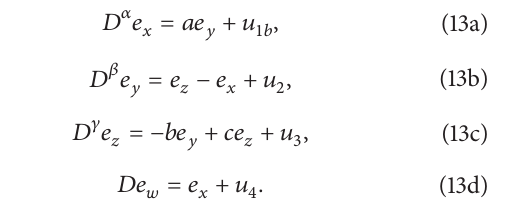
Figure4:Thegeneralsynchronizationof(a),(b)the 𝑥 and 𝑦 responseswhen {𝛼,𝛽,𝛾,𝑎 1 , 𝑏 1 , 𝑐 1 , 𝑎 2 ,𝑏 2 ,𝑐 2 } = {0.96, 0.96, 0.96, 4, 1, 0.65, 4, 1, 0.65} for Case A, (c) the 𝑥 response under the same condition with additive noise with amplitude 0.1, (d) the response when , 𝑏 , 𝑐 , 𝑎 ,𝑏 ,𝑐 } = {0.96, 0.96, 0.96, 4, 1, 0.65, 4, 1, 0.65} for Case B, and (e) Case {𝛼,𝛽,𝛾,𝑎 1 1 1 2 2 2